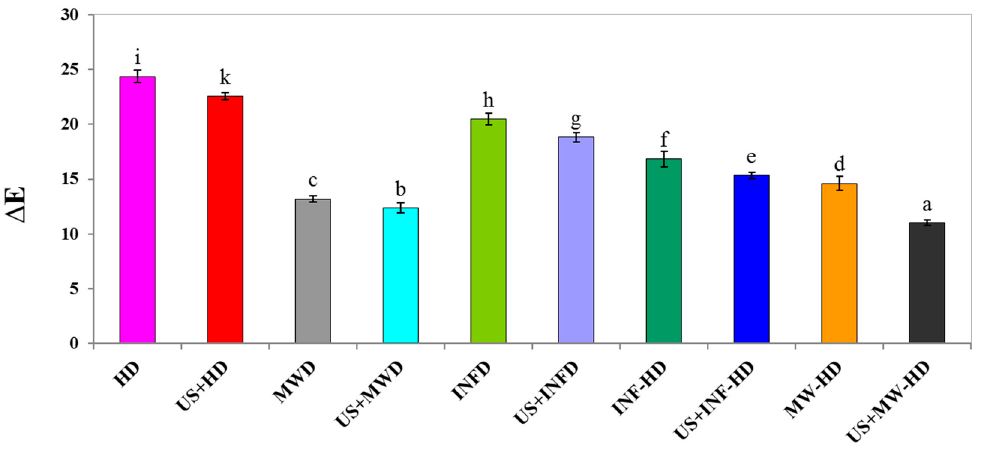
Figure 3. The effects of the different drying methods on the color values of